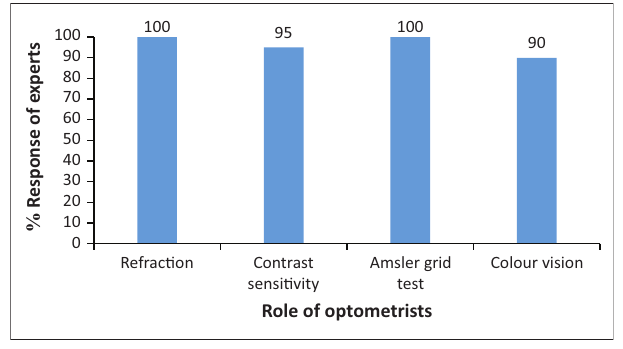
FIGURE 7: Percentage response by experts on the role of optometrists in the management of patients with diabetes